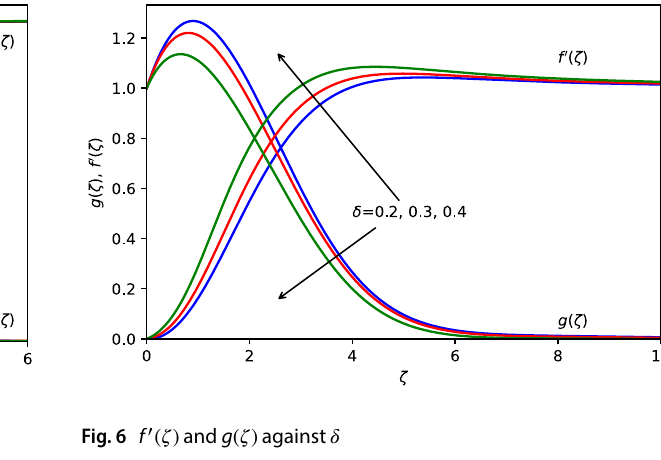
Fig. 4 f � ( 𝜁 ) and g ( 𝜁 ) against M